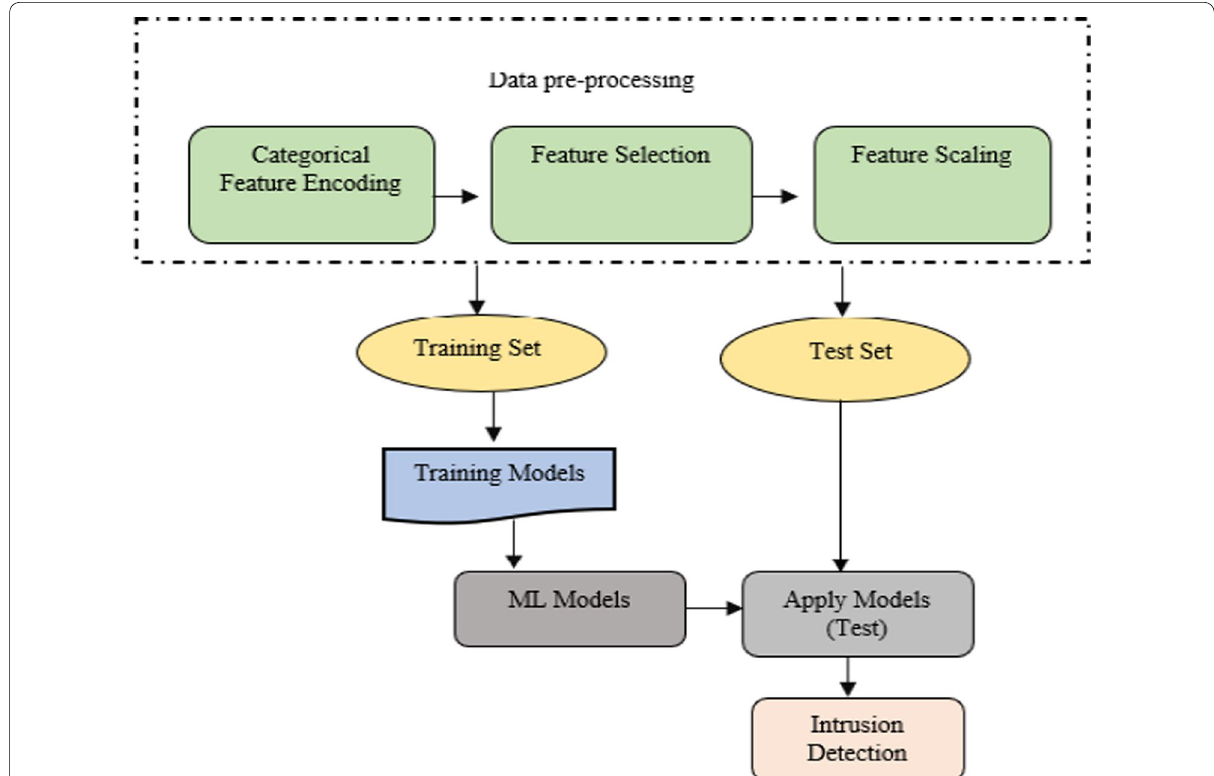
Fig. 7 Proposed ML-based IDS